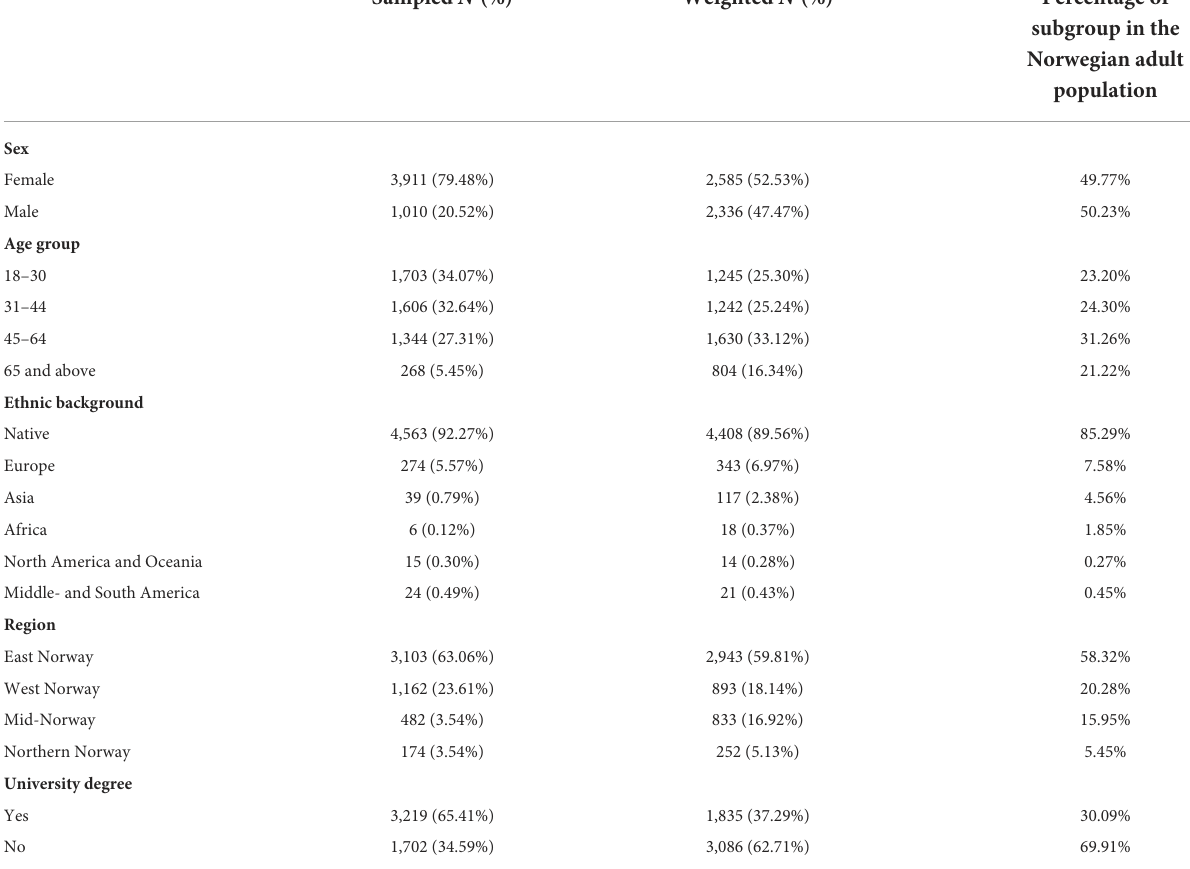
A table revealing the proportion of the sampled participants. All oversampled and undersampled subgroups were assigned appropriate weights to reflect their known distribution in the